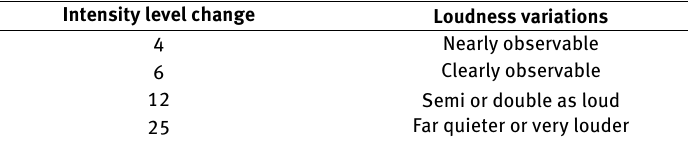
Table 2: Various effects of loudness with variation in pressure levels